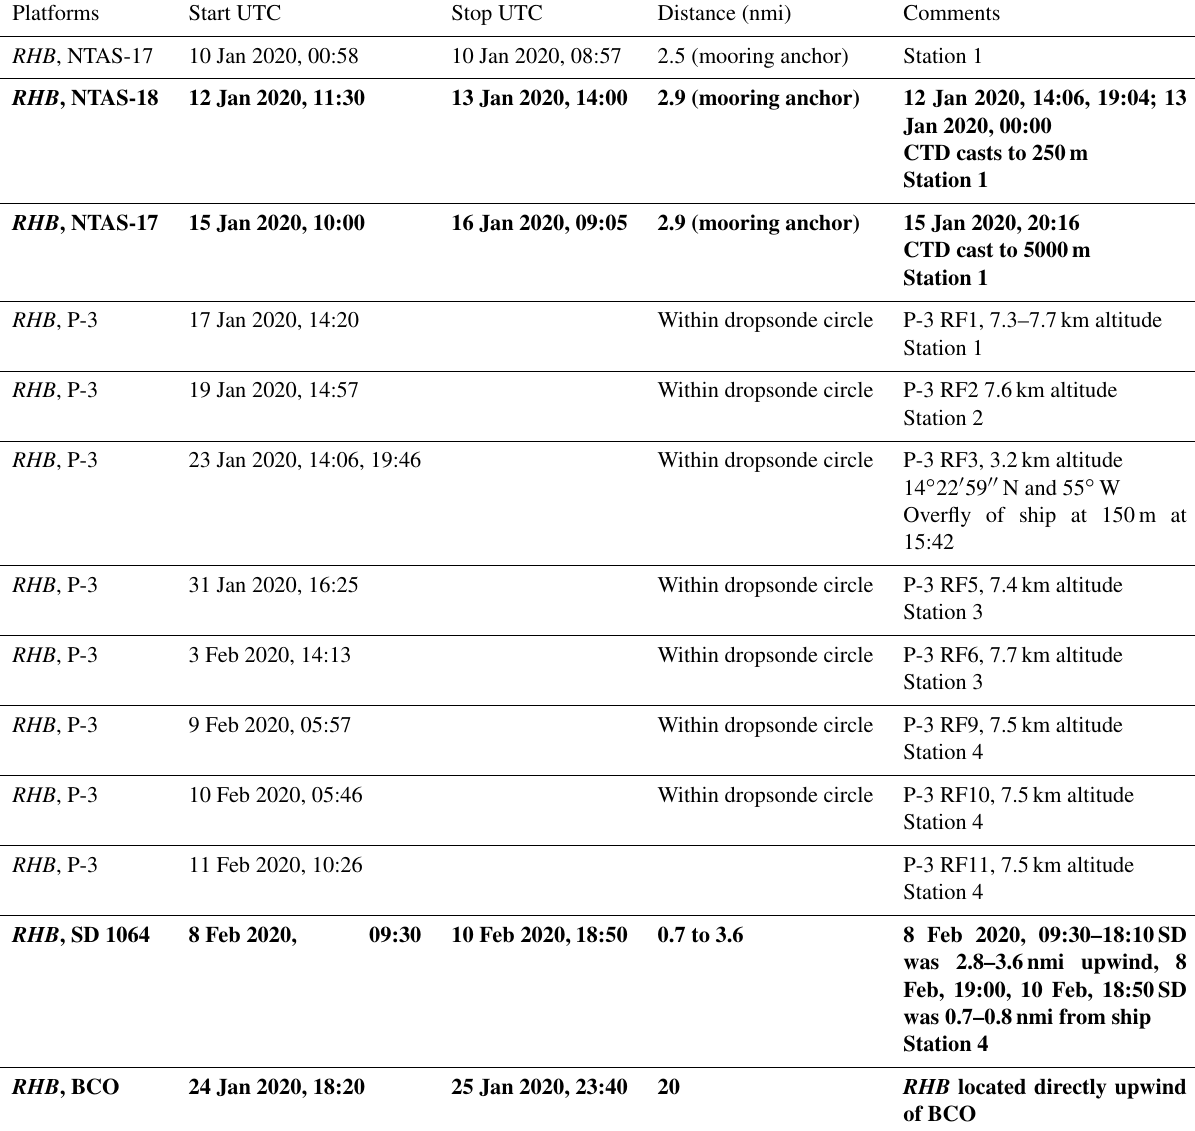
Table 3. Times when platforms were within relatively close proximity providing the potential for inter-platform comparisons. Also given are distances between platforms during the comparisons. Results from inter-platform comparisons reported here are indicated in bold. Distances between RHB and NTAS refer to distance to the mooring anchor. Distance to buoys was between 0.25 and 3nmi. Platforms Stop